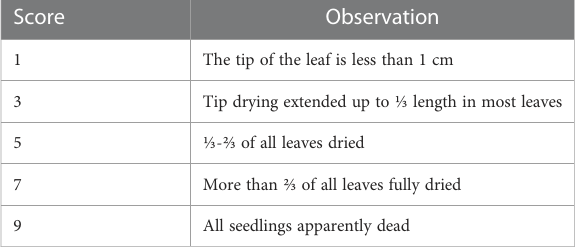
TABLE 1 The scale for leaf score of heat